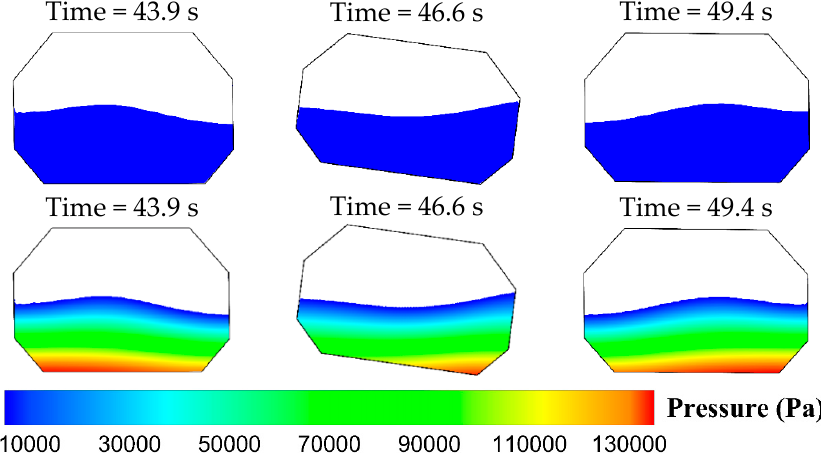
Figure 9. Snapshots of free surfaces ( first line ) and corresponding pressures ( second line ) in the case T = 11.0 s at various moments.